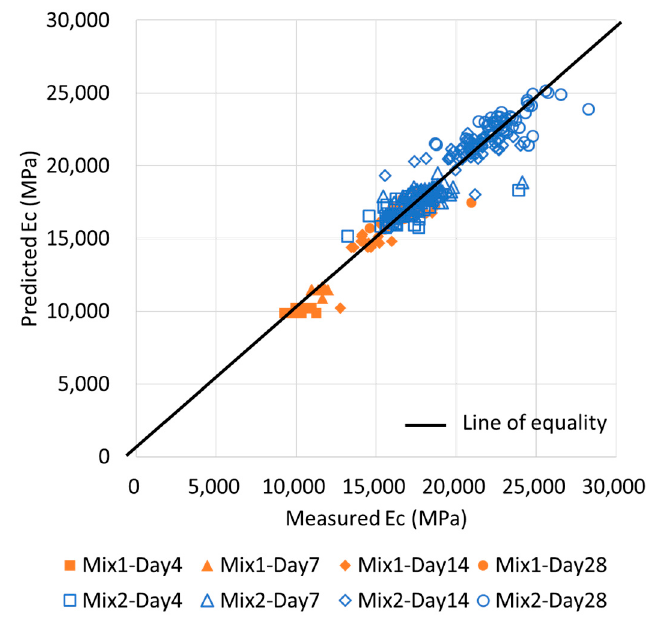
Figure 11. Relationship between measured Ec (experimental values) and predicted Ec (theoretical values) by the ensemble.